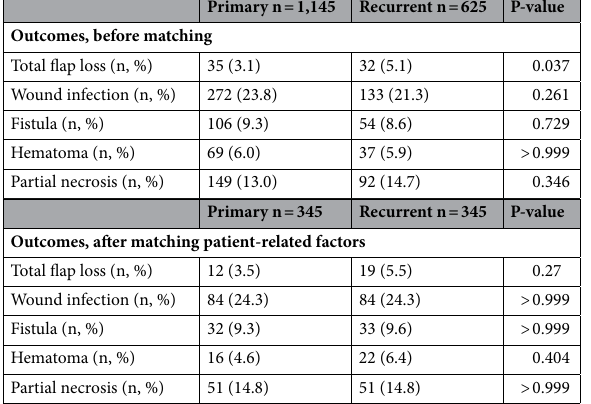
Table 2. Comparison of outcomes between the primary and recurrent groups after propensity score matching of patient-related factors.